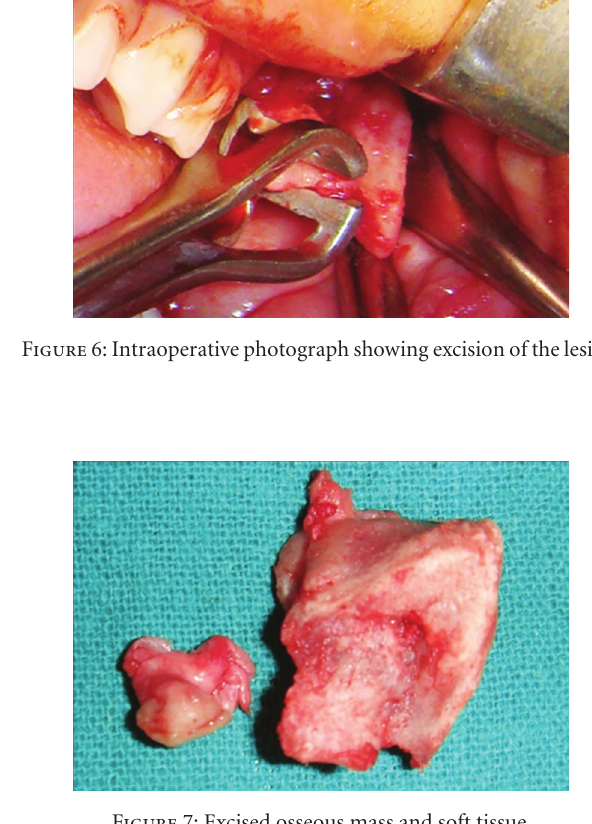
Figure 7: Excised osseous mass and soft